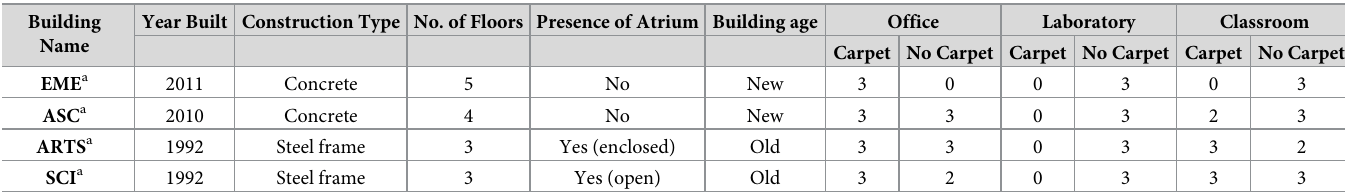
Table 1. Dust sample collection